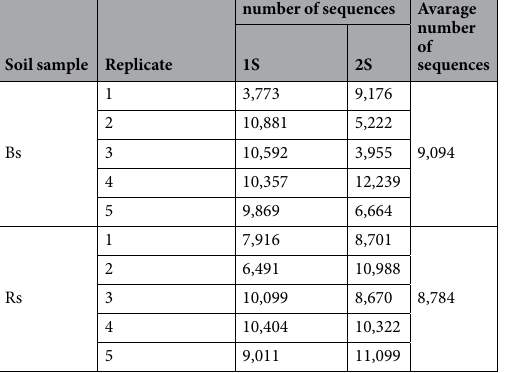
Table 1. Number of sequences obtained from the different replicates of Bulk soil (Bs) and soil associated with the roots of V. vinifera cv. Pinot Noir (Rs) at the two sampling times (1 S = first sampling in May; 2 S = second sampling in July).